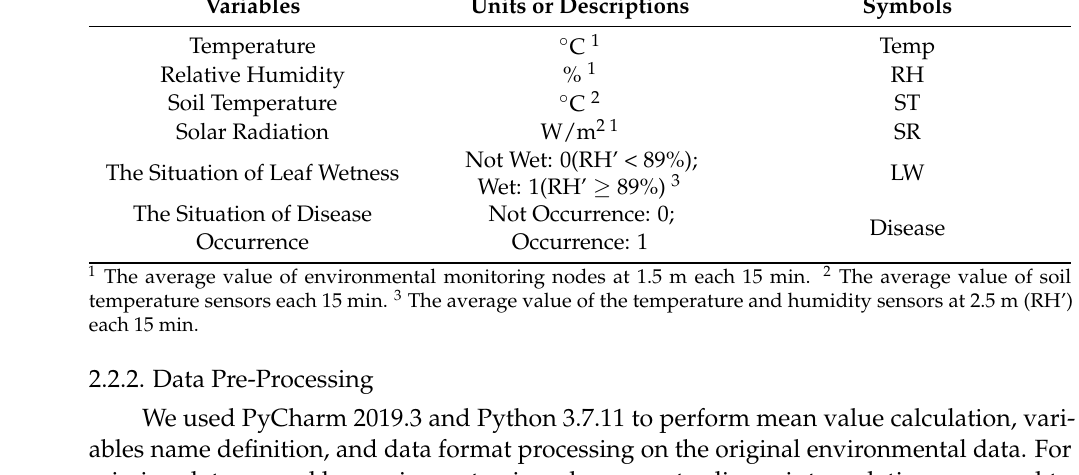
Table 1. Model variables setting, units or descriptions, and symbols definition. Variables Units or Descriptions Symbols Temperature ◦ C 1 Temp Relative Humidity % 1 RH Soil Temperature ◦ C 2 ST Solar Radiation W/m 2 1 SR Not Wet: 0(RH’ < 89%); LW The Situation of Leaf Wetness Wet: 1(RH’ ≥ 89%) 3 The Situation of Disease Not Occurrence: 0; Occurrence Occurrence: 1